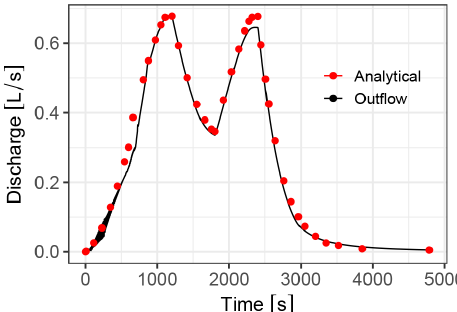
Figure 8. Simulated and analytical discharge for the analytical case of rainfall in a